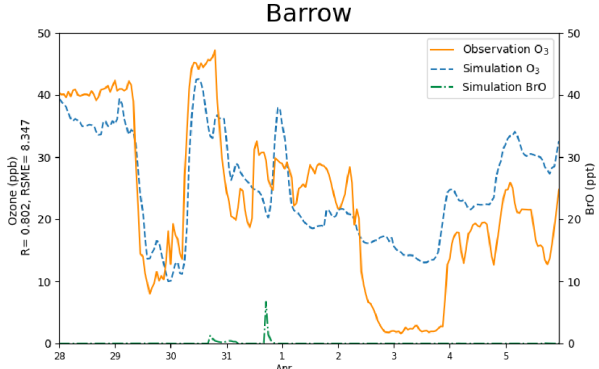
Figure 4. The surface ozone (ppb) obtained from simulations and observations together with the simulated BrO at Barrow from 28 March to 5 April 2019. The correlation coefficient R and the root-mean-square error RMSE are also presented on the vertical